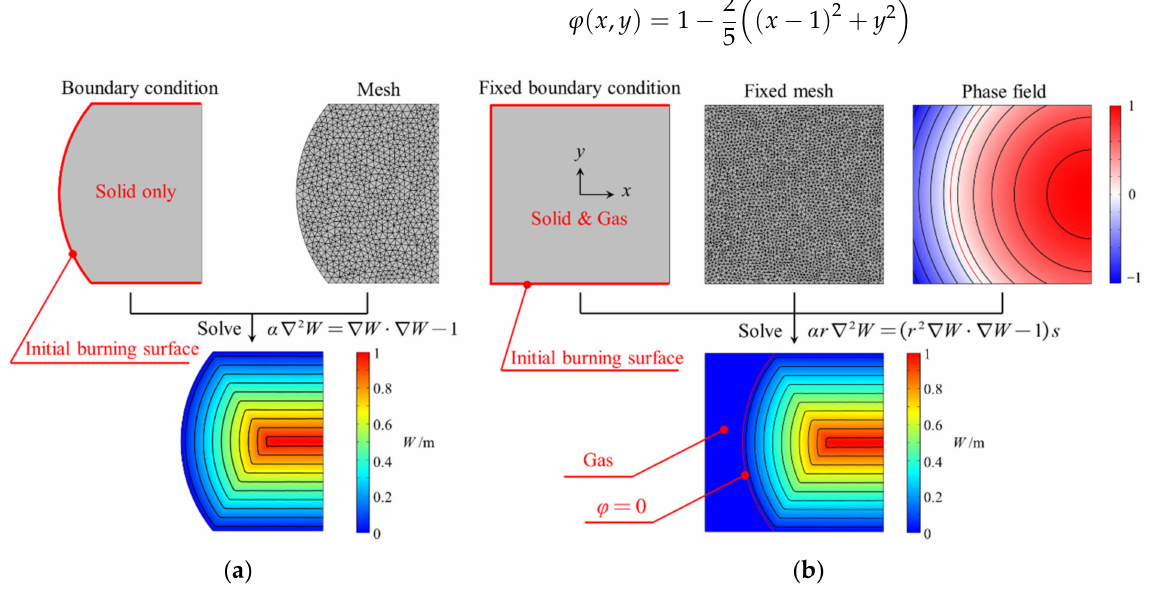
Figure 8. Illustration of burn-back analysis methods: ( a ) PEF method and ( b ) ϕ —PEF method. The W field is obtained by solving the algebraic equation derived from Equation